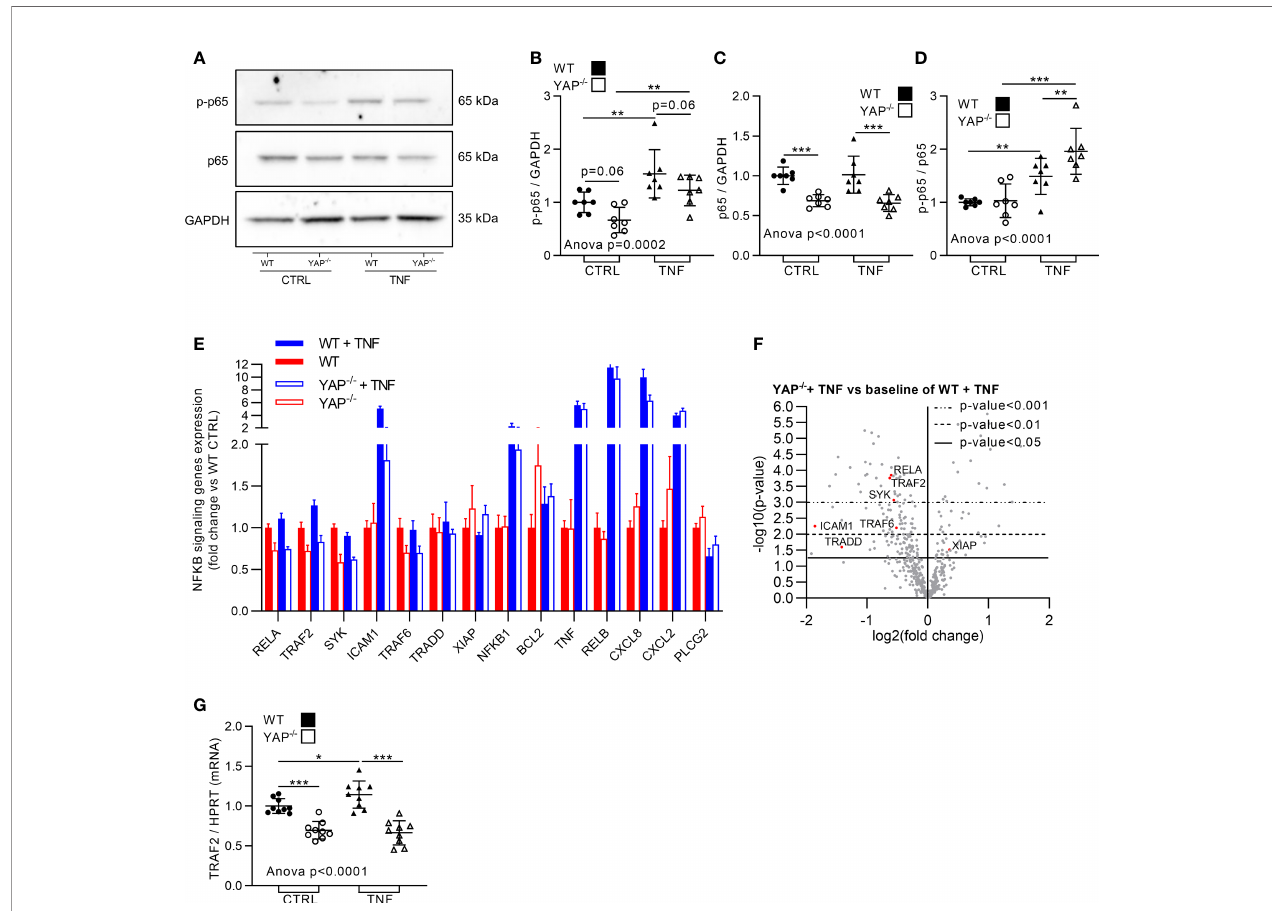
FIGURE 4 | YAP modulates TNF effect on NF- k B pathway. HEK293 cells were cultured and treated with TNF as described in Figure 1 . (A – D) Representative western blot of NF- k B p65 phosphorylation on serin 536 (active form, p-NF- k B), NF- k B p65 and GAPDH for WT and YAP − / − control or TNF treated cells (A)